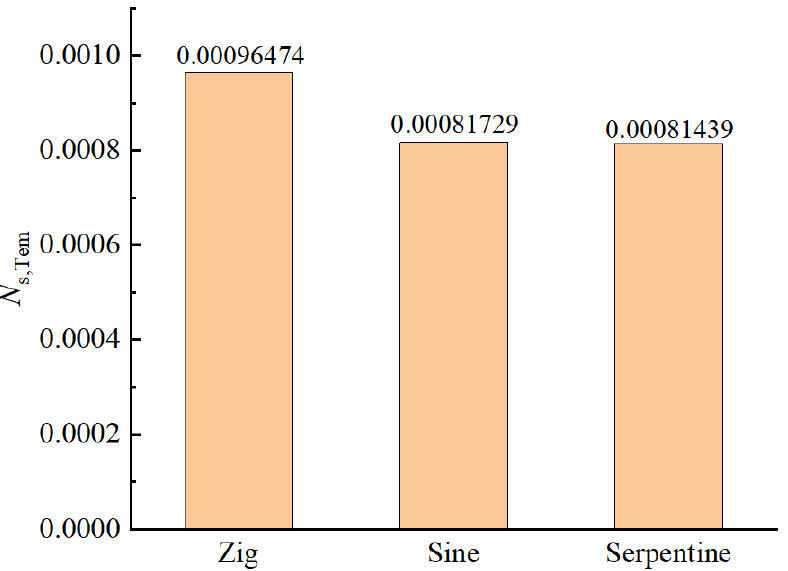
Figure 24. The heat transfer Hesselgreaves number of one period in different configurations.